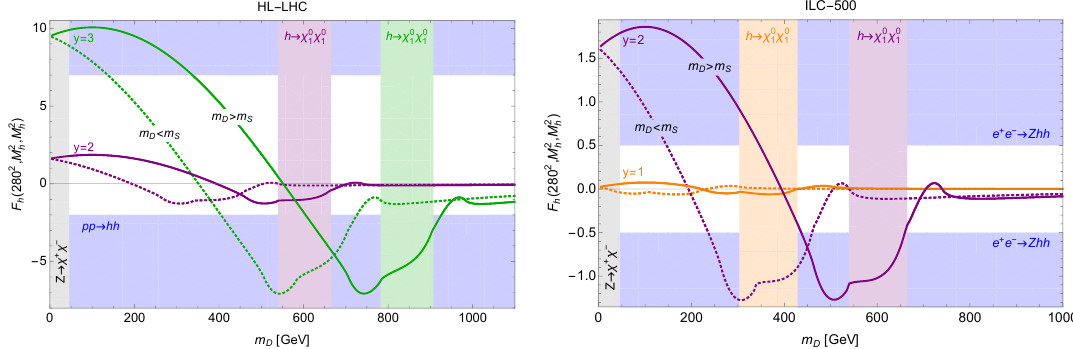
Figure 4 . Anomalous triple Higgs coupling, Re[ F h ], as a function of the mass parameter m D for (cid:12)xed Yukawa couplings y at the HL-LHC (left) and a future ILC with p s = 500 GeV (right). Plain/dotted lines correspond with m D measurements. In orange, purple, and green regions, invisible Higgs decay h m D m S = 200 GeV and y = 1 ; 2 ; 3, respectively. Blue regions can be probed at the HL-LHC and (cid:0) ILC-500,